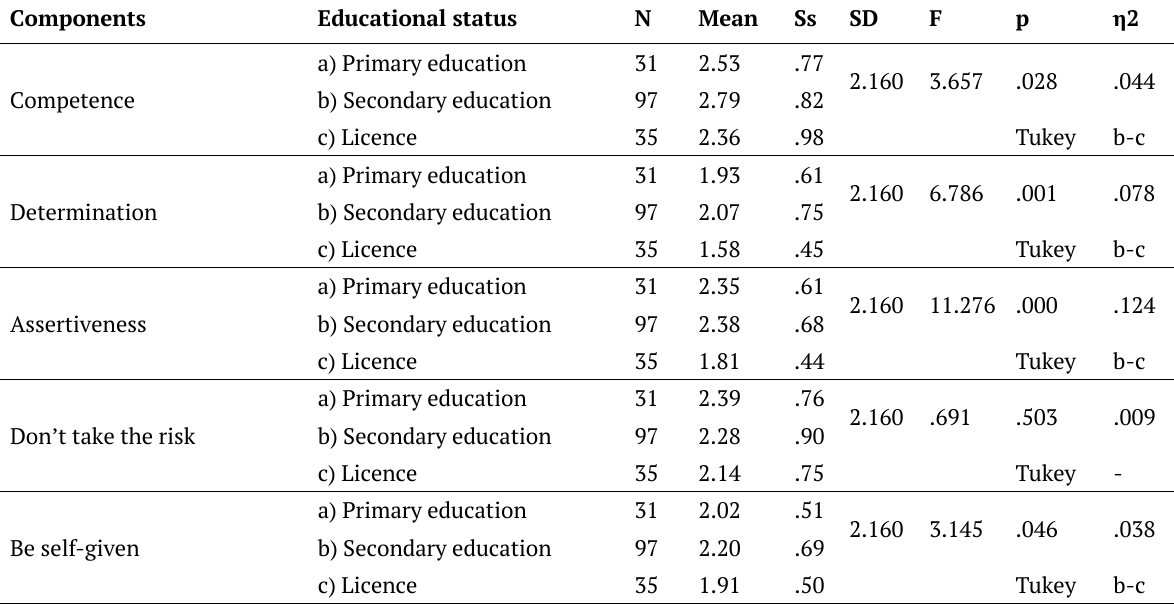
Table 4. ANOVA results of courage in sports and its sub-dimensions according to educational status variable N=163.